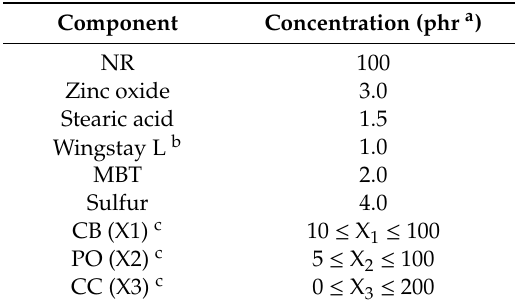
Table 1. Rubber compound formulations examined here.